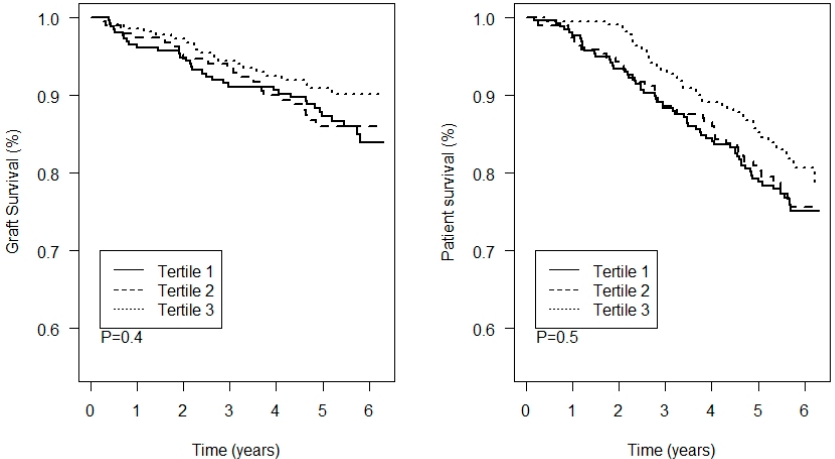
Figure 3. Kaplan–Meier analyses for death-censored graft survival and patient survival per tertile of plasma thallium. The p -value represents the significance of difference between the groups as assessed by a log-rank test. Table 2. Univariable and adjusted Cox regression analyses of the associations of plasma thallium with graft failure and mortality.